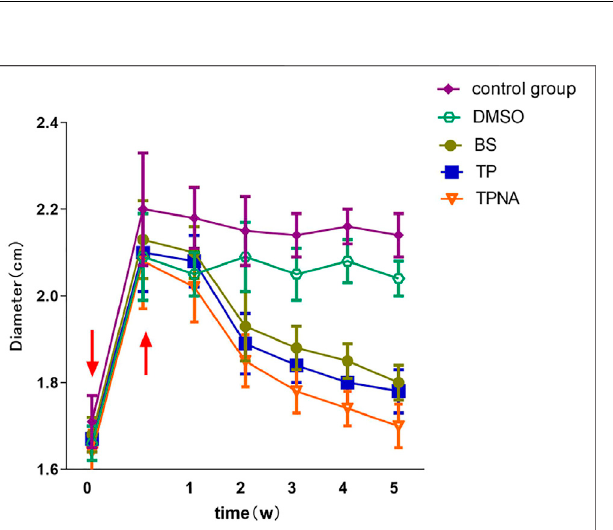
Frontiers in Pharmacology |